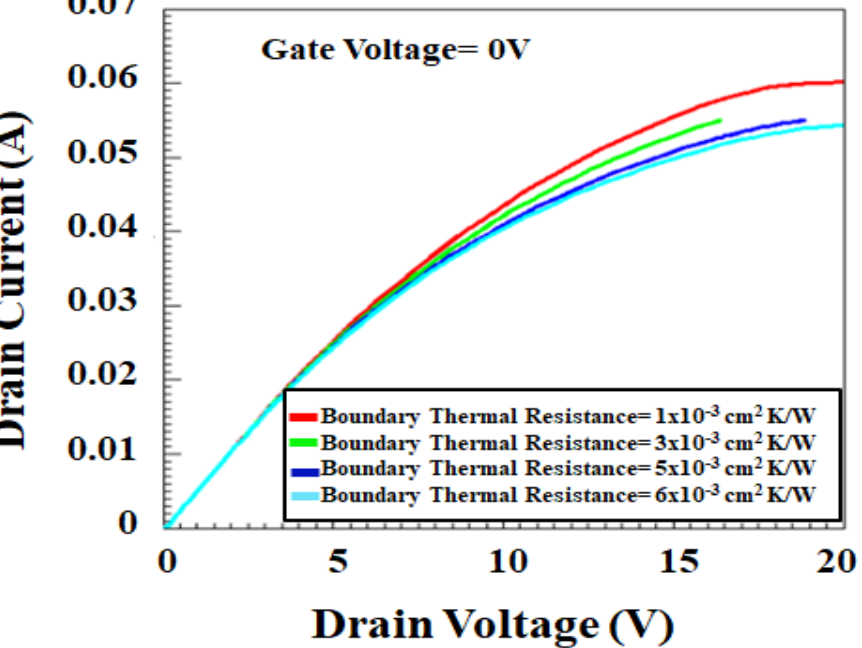
− V d d based on self-heating mode for various thermal